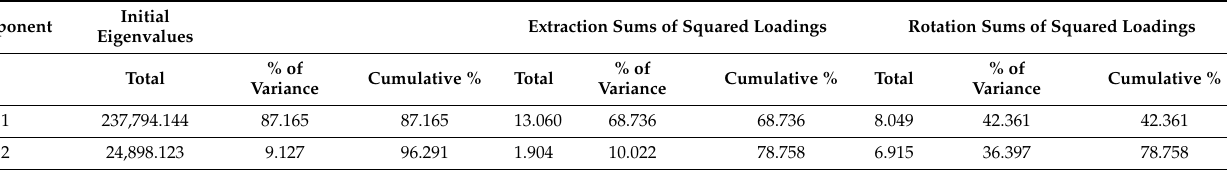
Table 3. Factor Analysis—Total Variance Explained.